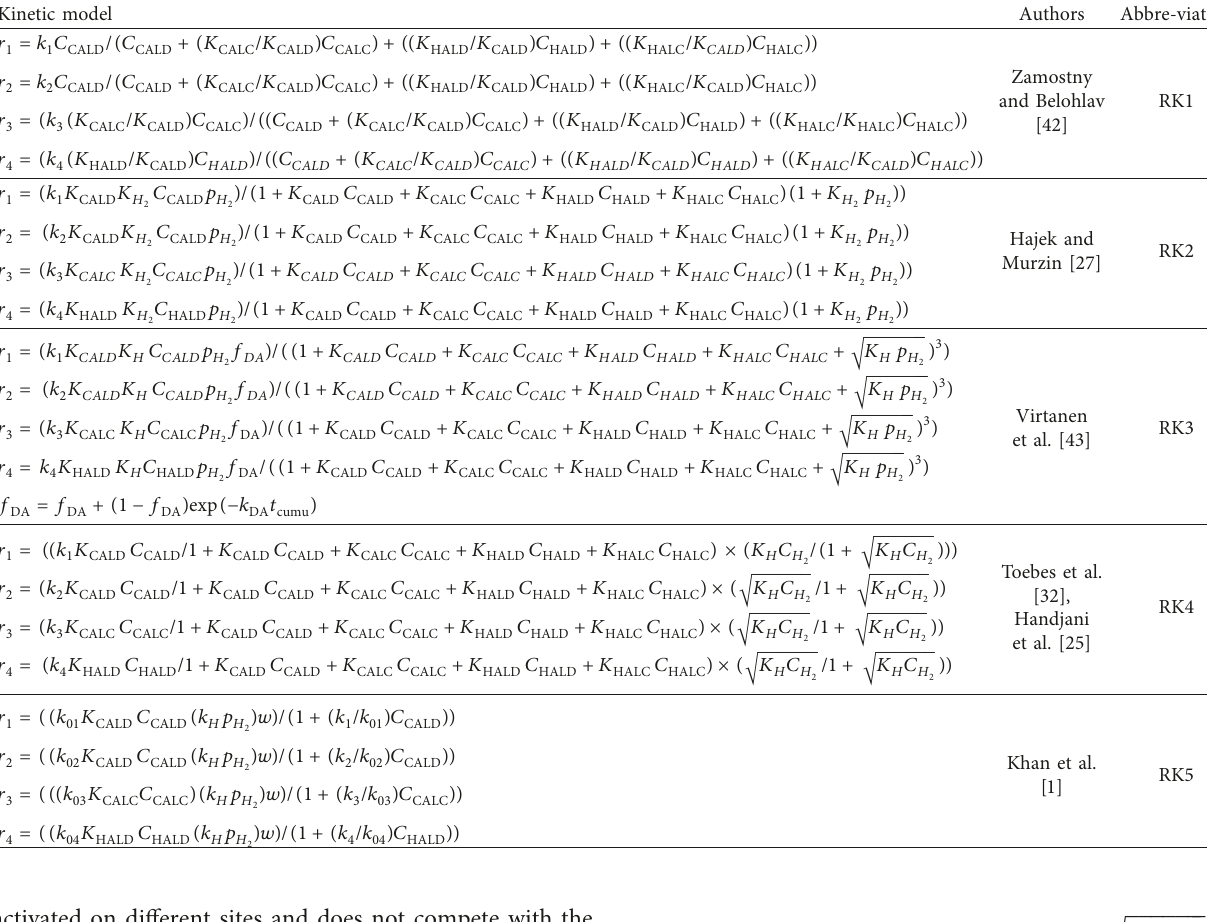
Table 1: Reaction kinetic models for the liquid-phase hydrogenation of